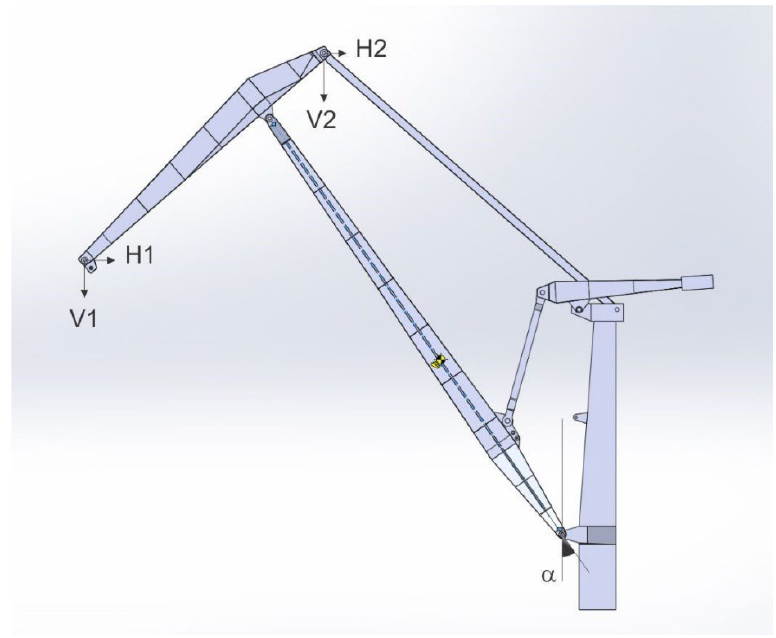
Figure 4. Variables that define the study.